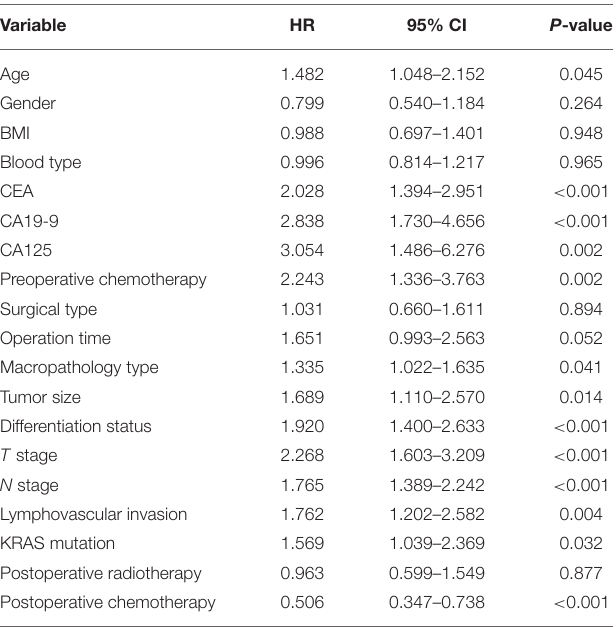
TABLE 2 | A univariate Cox regression analysis for overall survival (OS) of the training dataset.